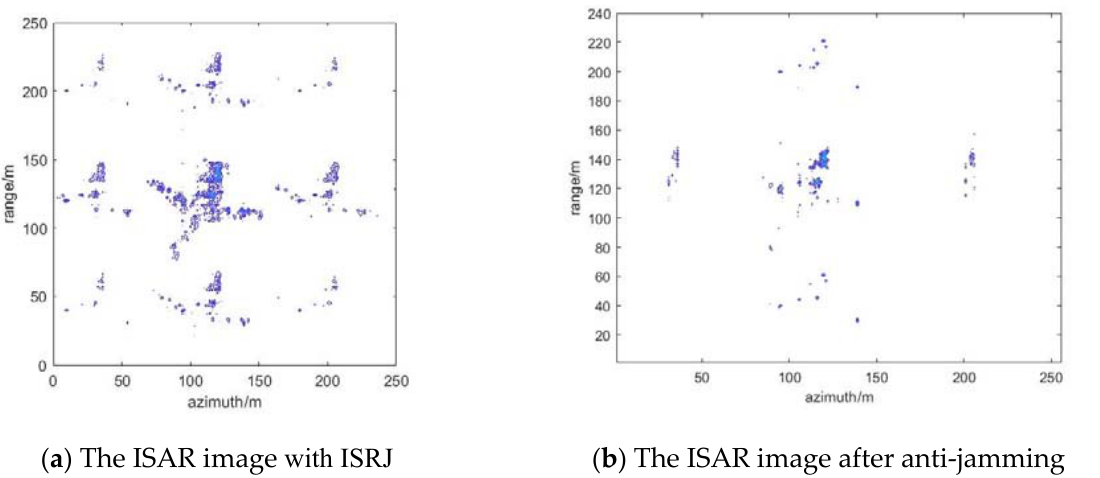
Figure 15. The results of ISRJ jamming and anti ‐ jamming both in the fast time domain and in the slow time domain.